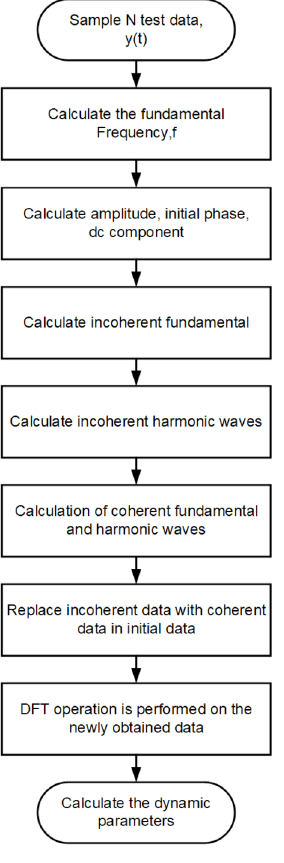
Figure 4. Process step diagram.